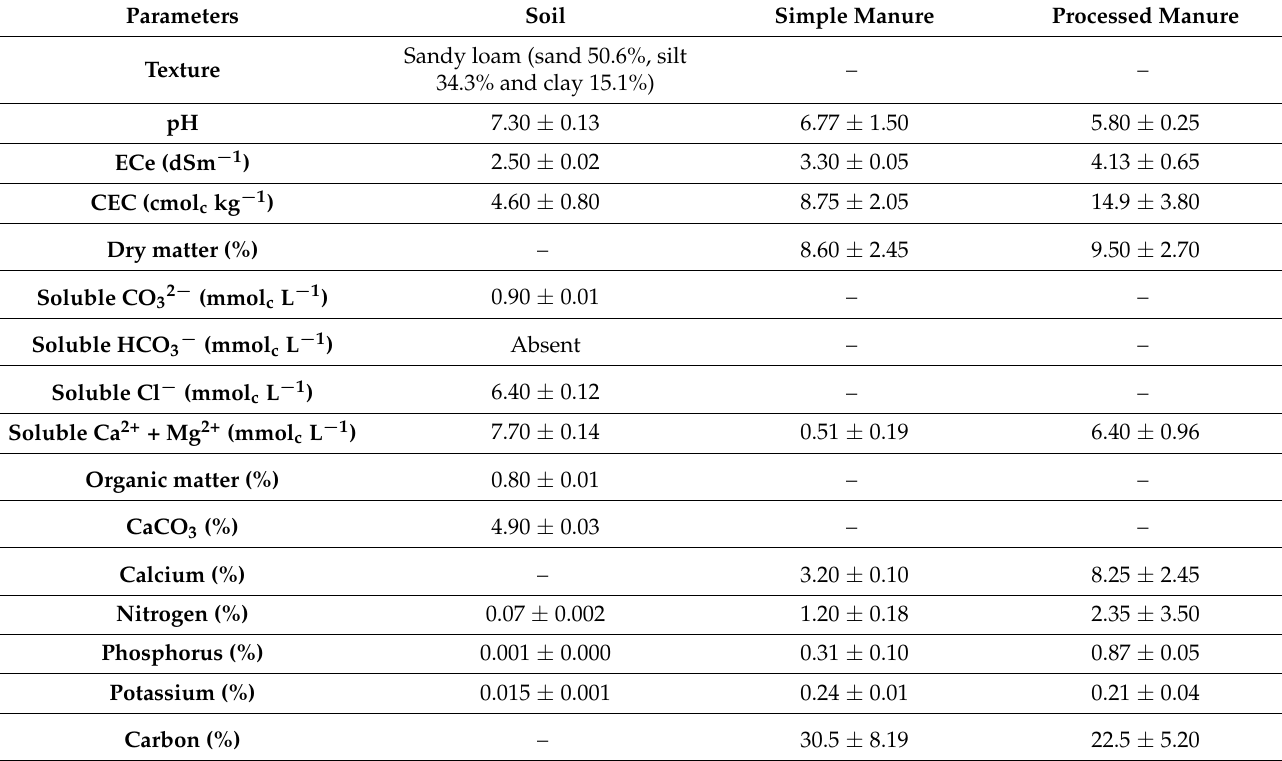
Table 1. Physio-chemical characteristics of soil, simple, and processed manure used in this study. Parameters Soil Simple Manure Processed